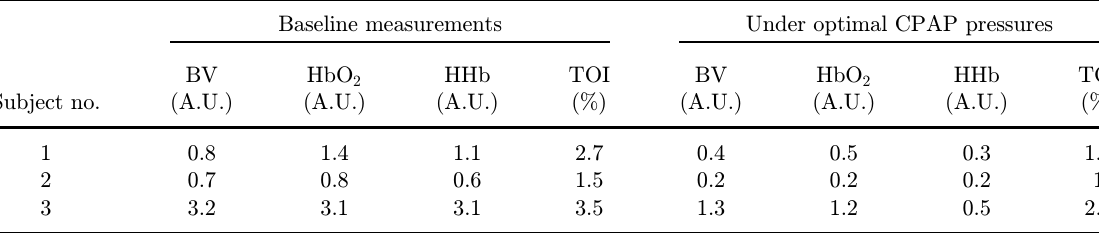
Table 3. The SDs of cerebral hemodynamics during baseline measurements and under optimal CPAP